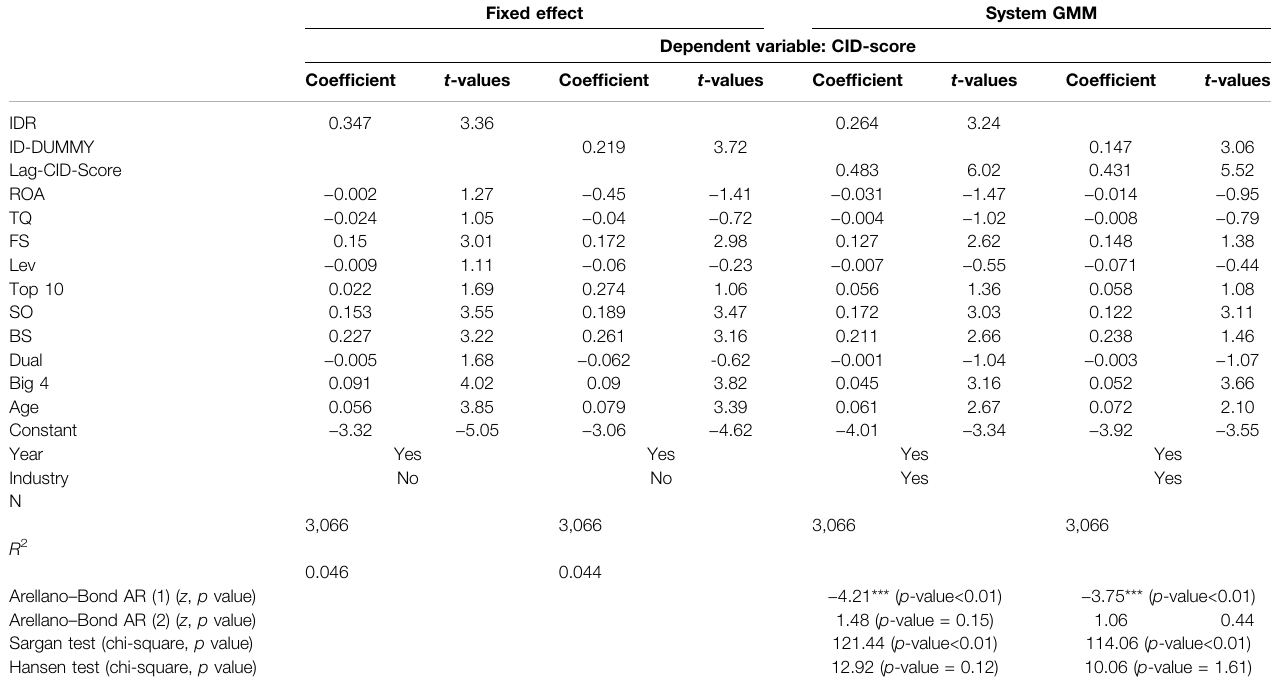
TABLE 8 | Effect of Independent directors on CID with fi xed effect and GMM